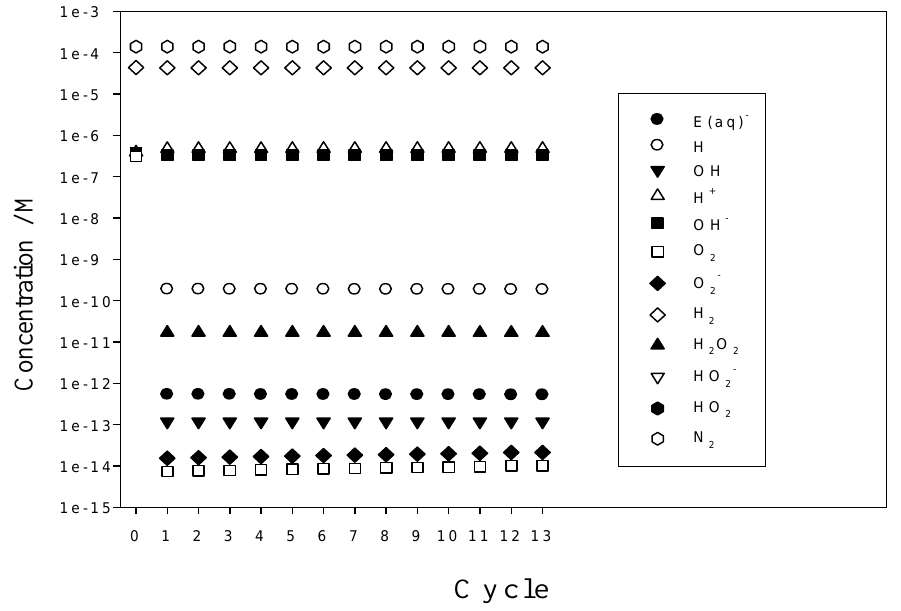
Figure 36. Calculated average concentrations of radiolysis species at the Plasma Flux Area inlet as a function of the number of revolution cycles. [H 2 ] Inlet = 1 cc (STP)/kg H 2 O.